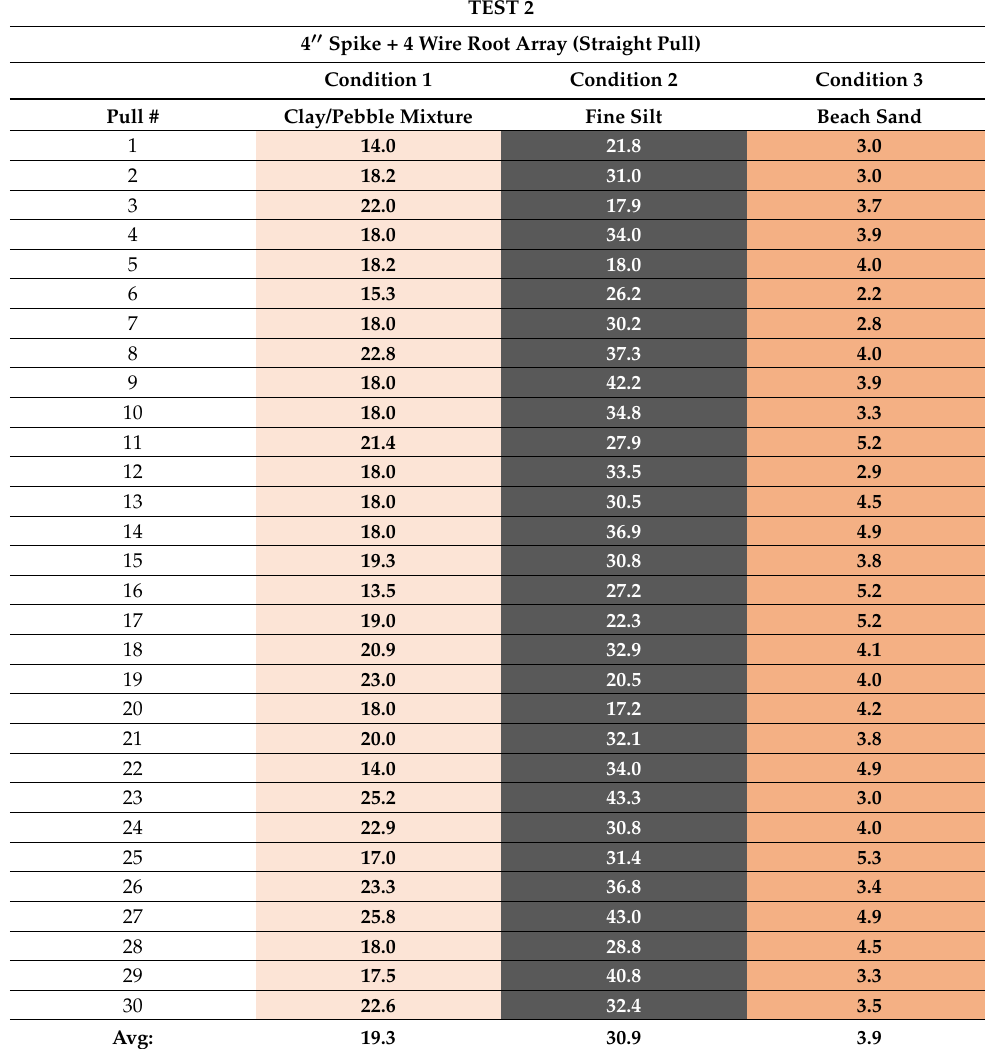
Table A2. Test 2: complete anchoring failure tension data